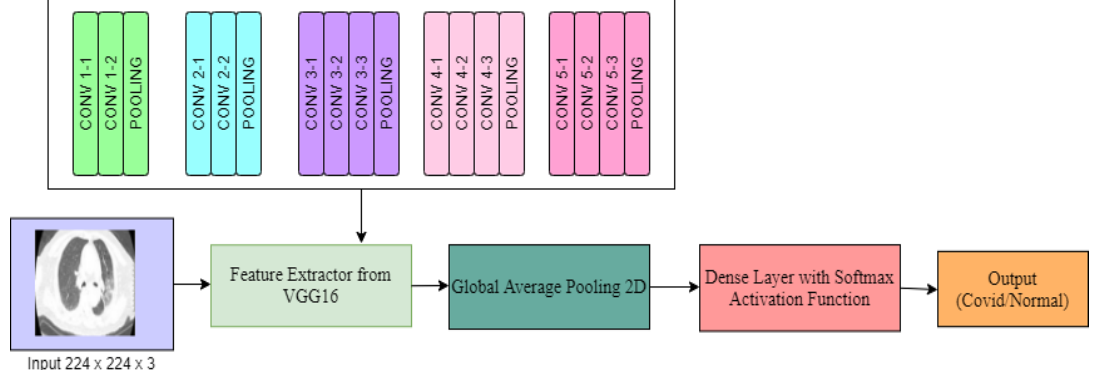
Figure 1. Transfer learning architecture based on VGG16.